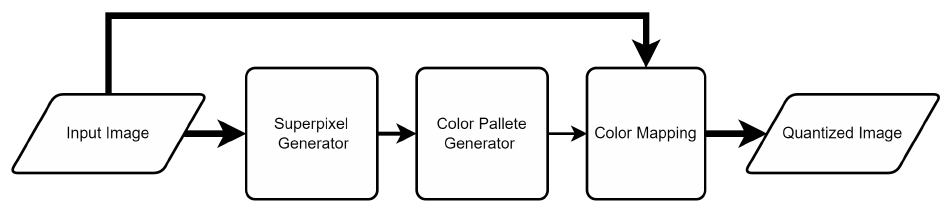
Figure 1. General concept of the proposed superpixel CQ